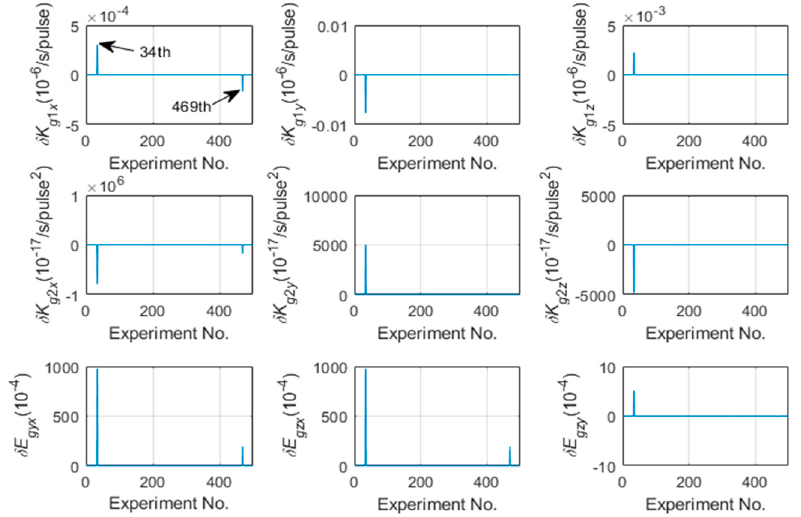
Figure 4. The calibration errors of gyroscope without the initial values estimation.